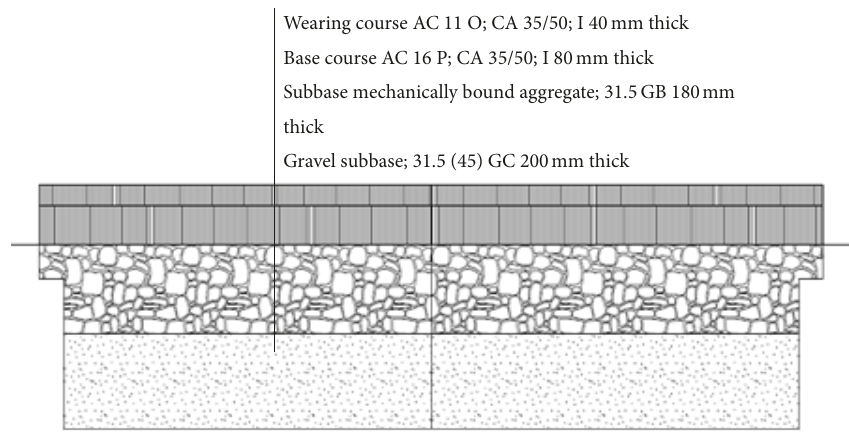
Figure 1: Pavement